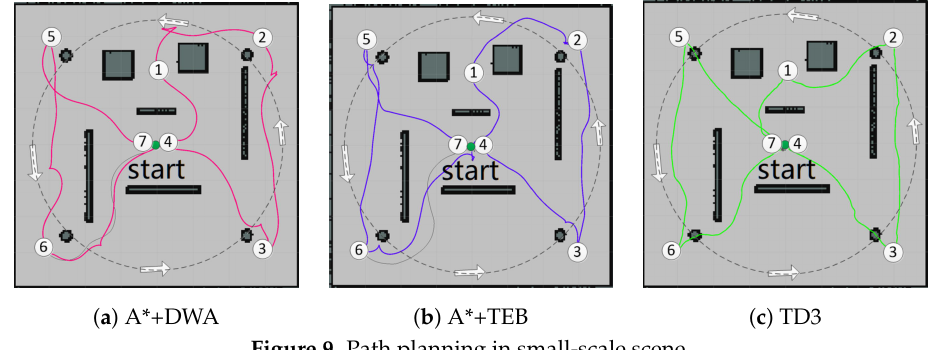
Figure 9. Path planning in small-scale scene.